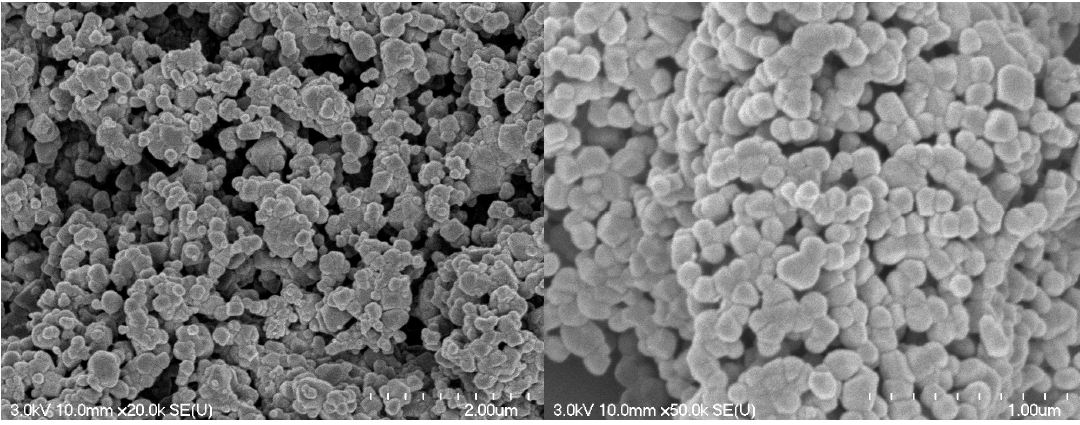
Figure 6. SEM of fresh Ni-UGSO.